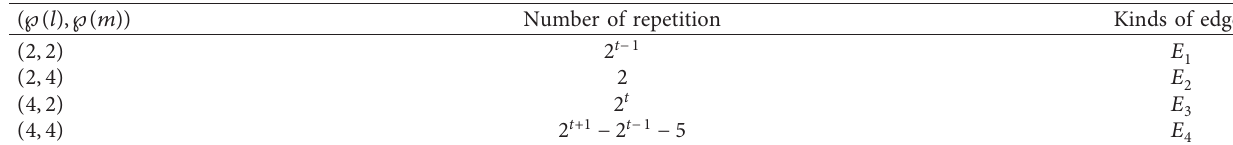
Table 4: Edge partition of CBT ( t ) with t